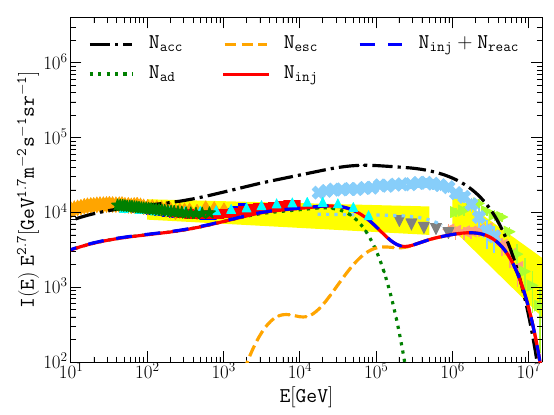
Figure 2. Proton spectrum from a core-collapse SN with total explosion energy E SN = 6 × 10 51 erg, Mass-loss rate ˙ M = 10 − 5 M (cid:12) / yr and e ffi ciency ξ = 5 %, the SN rate is ν SN = 0 . 06 / century. The black dot-dashed line corresponds to a naive estimate of all accelerated protons. The dotted green lines correspond to par- ticles trapped inside the SNR and su ff ering adiabatic losses and released at the end of the adiabatic phase. The orange dashed line corresponds to particles constantly escaping in the ISM. The solid red line corresponds to the sum of trapped and escaping particles. The dashed blue line indicates that di ff usive shock re-acceleration does not play a significant role. The data points and yellow area correspond to data from various experiments as in